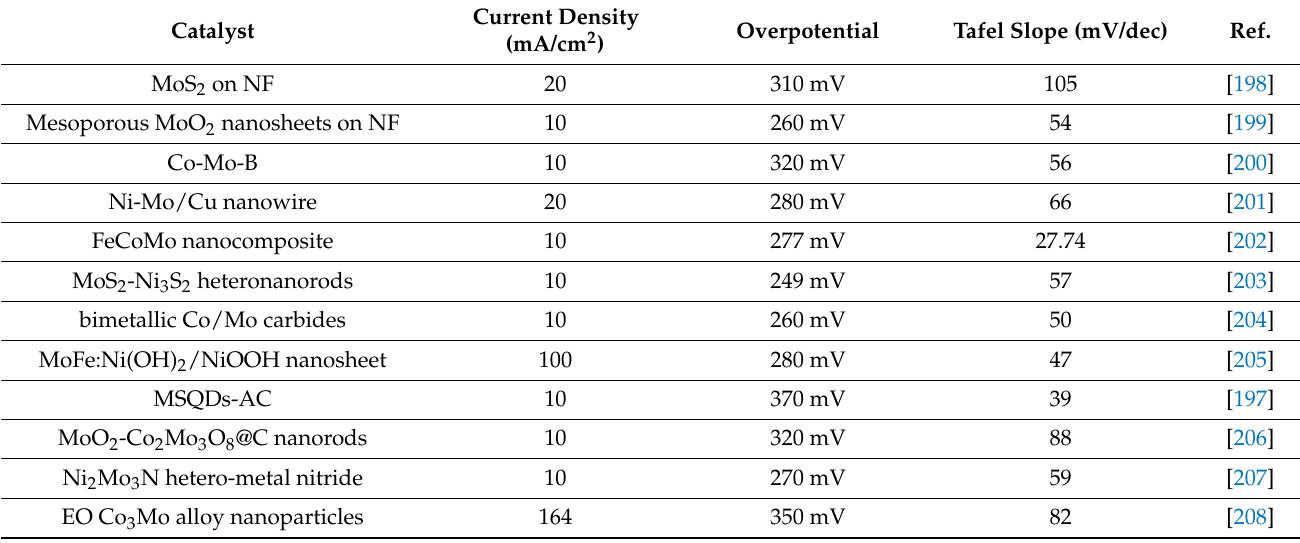
Catalyst Current density